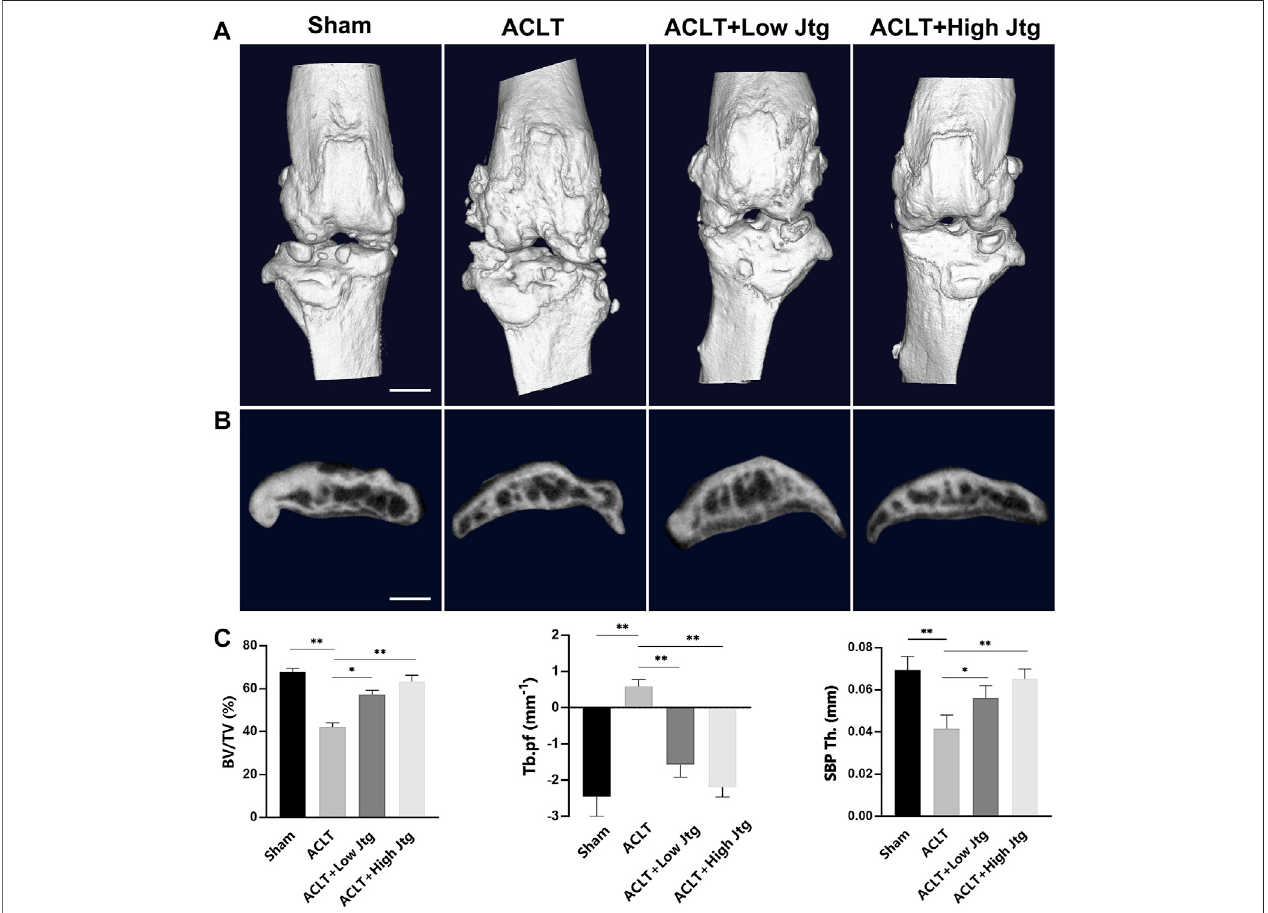
FIGURE4| Jtgrelievesabnormalsubchondralboneremodelinginamouseanteriorcruciateligamenttransection(ACLT)model invivo . (A) 3Dmicro-CTimagesof frontal views of the knee joints at 4 weeks after the sham operation or the ACLT operation. (B) 3D micro-CT images of sagittal views of subchondral bone medial compartment after sham operation or ACLT surgery, scale bar, 1 mm. (C) Quantitative micro-CT analysis of tibial subchondral bone of bone volume fraction (BV/TV), trabecular pattern factor (Tb.pf), and subchondral bone plate thickness (SBP Th). *Compared with the ACLT group (* p < 0.05; ** p < 0.01).